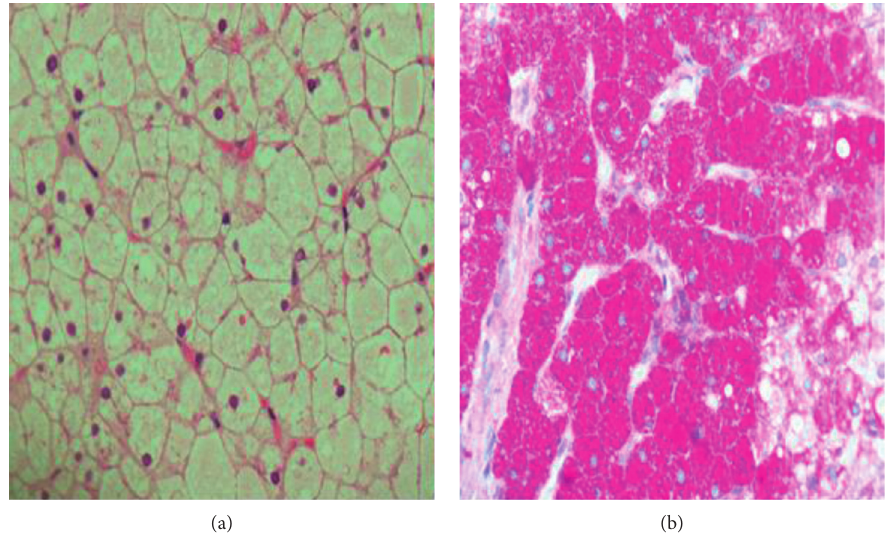
Figure 2: (a) Liver biopsy showing presence of abundant glycogen in the cytoplasm of hepatocytes and (b) a strongly positive PAS stain. Table 1: Comparison of nonalcoholic fatty liver disease and glycogenic hepatopathy. Nonalcoholic fatty liver disease (NAFLD) Glycogenic hepatopathy